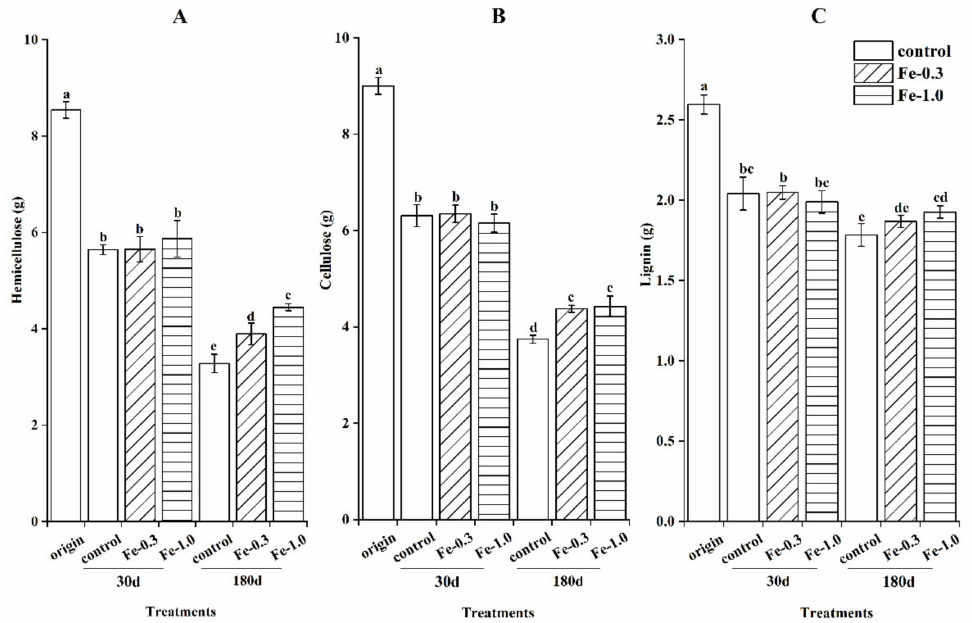
Figure 2. Temporal variations of lignocellulose in maize straw. ( A ) Hemicellulose content; ( B ) Cel- lulose content; and ( C ) Lignin content. Values are means with their standard errors represented by vertical bars. Different letters on the bars indicate the significant differences among the treatments ( p <